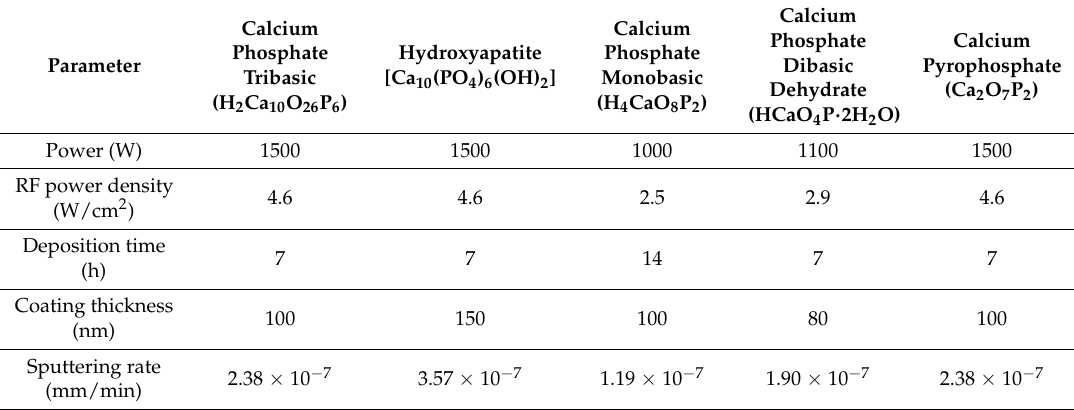
Table 1. Operational parameters employed during RF magnetron sputter